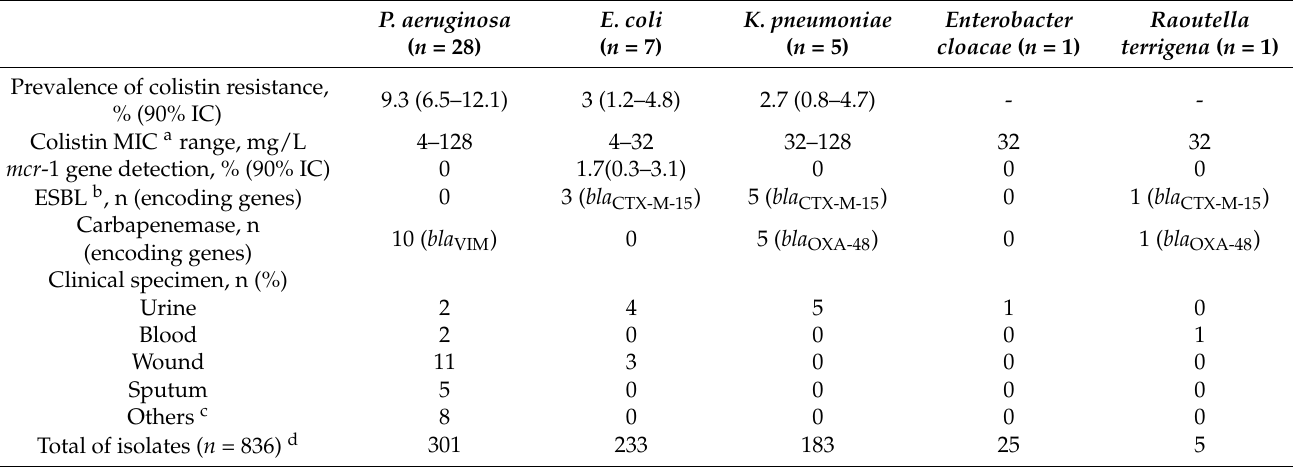
Table 2. Characteristics of colistin-resistant GNB